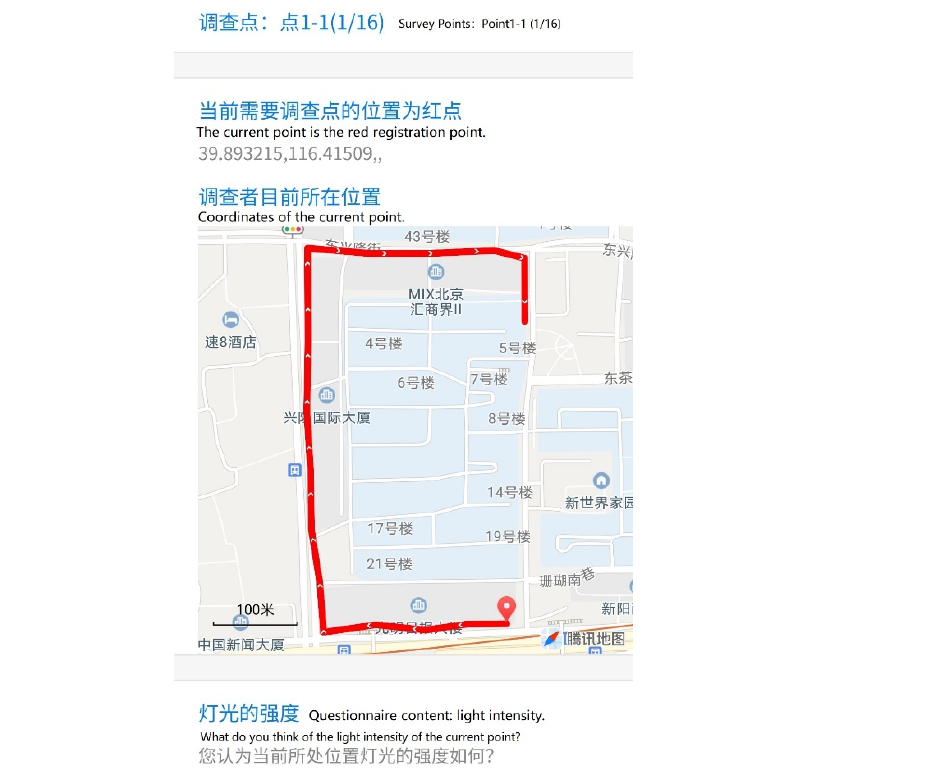
Table 1. Statistics of basic information of the